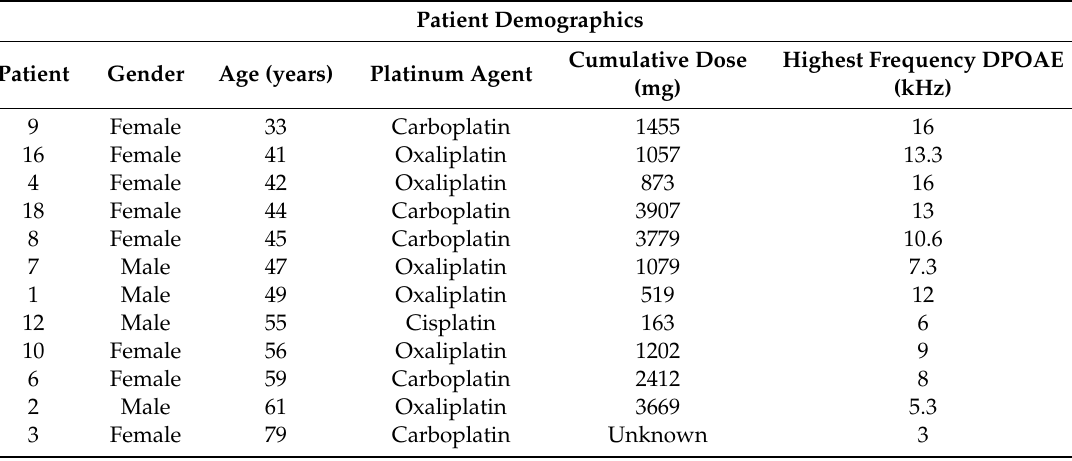
Table 1. Patient number—sorted by age (in years), gender, platinum agent received, cumulative dose, and frequency of highest distortion product otoacoustic emission (DPOAE) present at baseline determined from the gross frequency sweep data for all 12 patients included in this